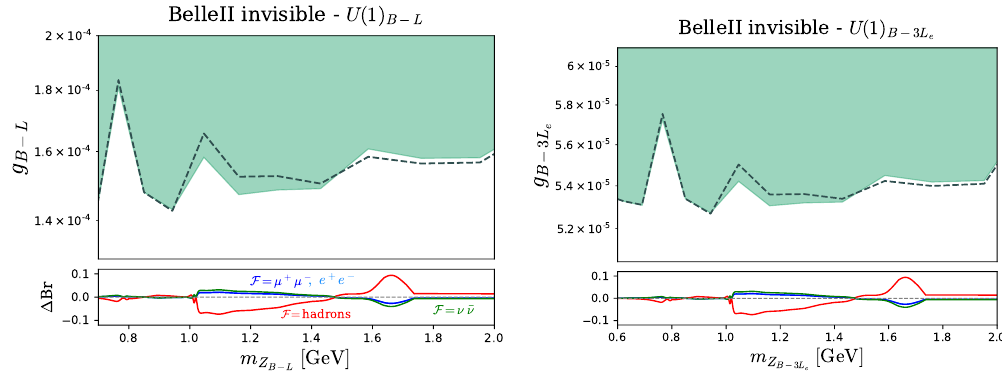
Figure 15 . Expected sensitivity for the B − L (left panel) and B − 3 L e (right panel) models for Belle II invisible searches according to our calculation (solid green) and DarkCast (dashed lines). In the bottom panels we show for each model the difference of the branching ratio between the two calculations. The 11 data points shown in the figure are taken from